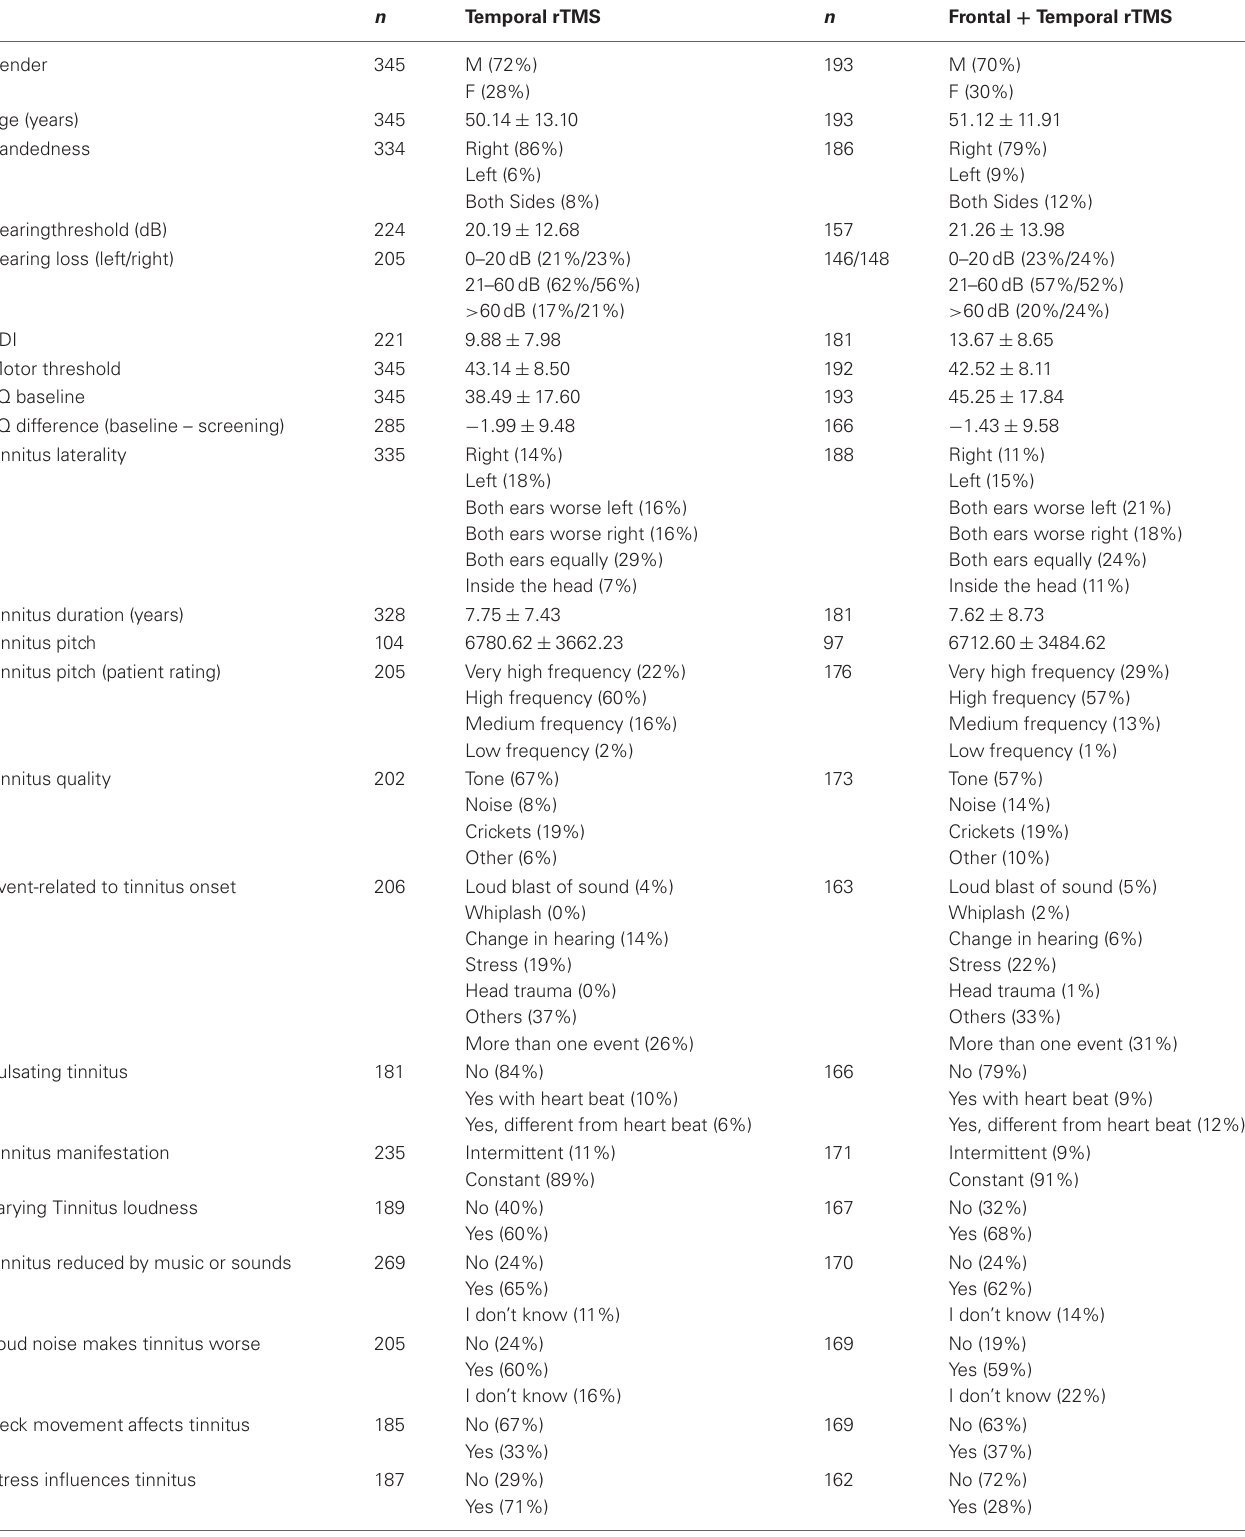
Table 1 | Demographical data and clinical characteristics for both treatment groups. n Temporal rTMS